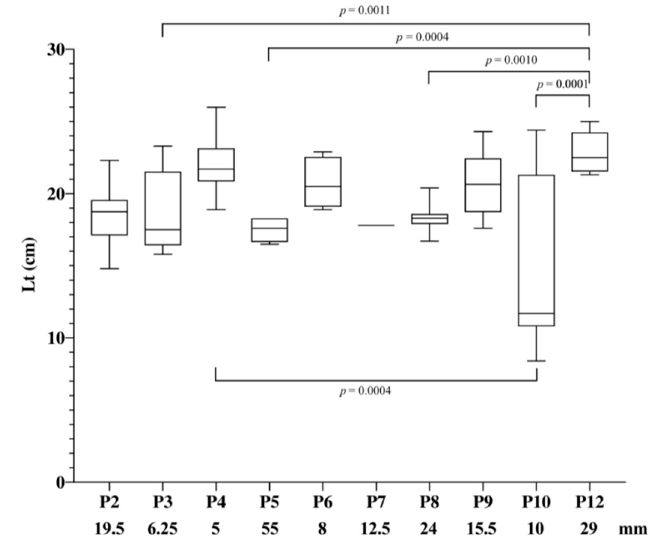
Figure 2. Distribution by total length (L t ) of brook trout in relation to panel (P) mesh size. Sex and age class were determined for all 90 specimens (59 females and 31 males, age class 0+ to 4+). The highest number of individuals was recorded for age classes 1+ and 2+ (Figure 3).